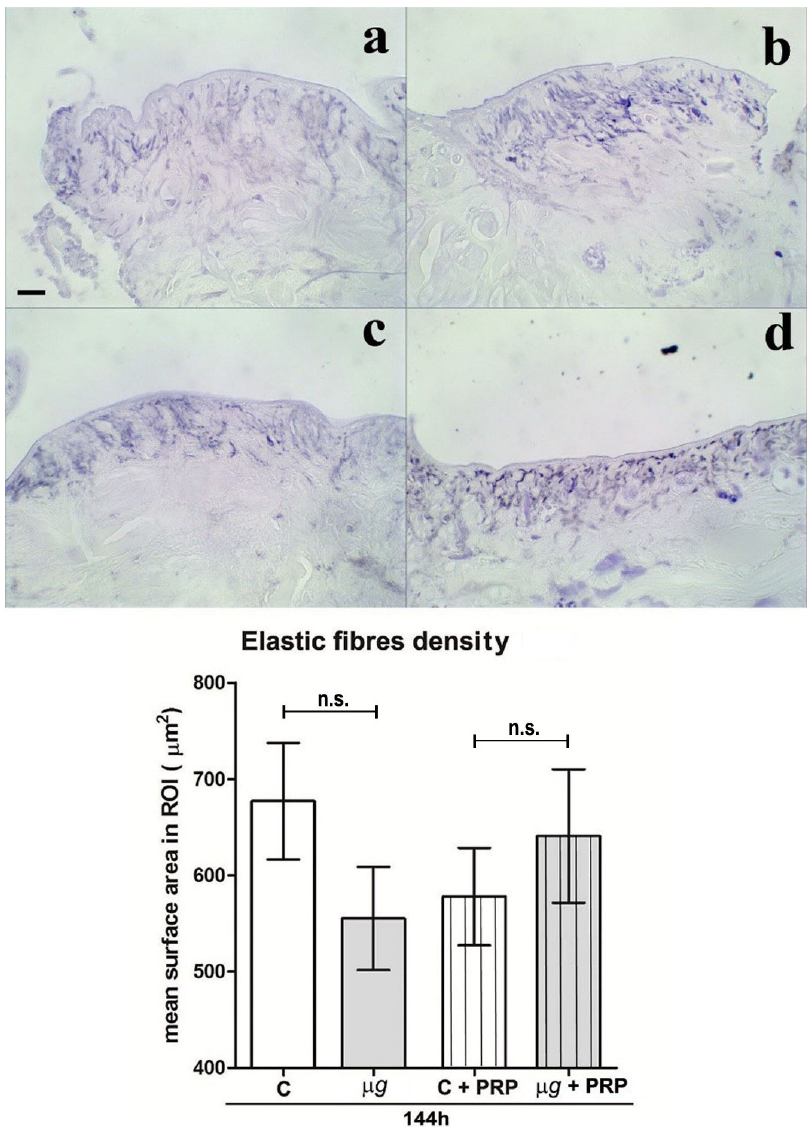
Figure 6. Effect of simulated μg and PRP treatment on in vivo model of sutured wound healing ( Hirudo medicinalis ): elastic fibre content after 144 h. Light microscopical analysis and morphometric quantitation of paraldehyde fuchsin-stained elastic fibres. 1 × g ( a ); μg ( b ); 1 × g + PRP ( c ); μg + PRP ( d ). Bar = 20 μm. Graph: C = 1 × g , ( n = 3); n.s. = not significant.